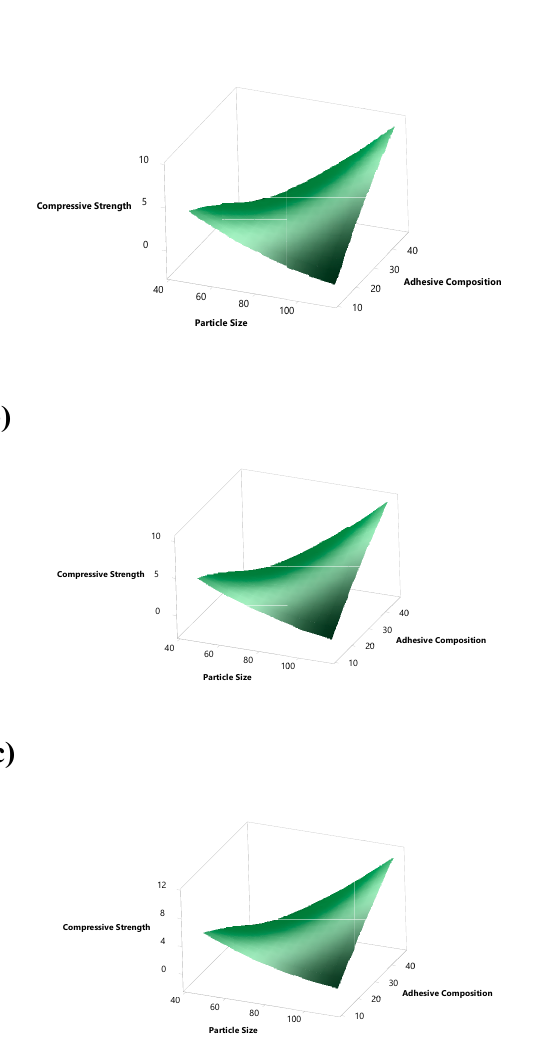
Figure 8. Graph and contour of surface response influences the adhesive composition and particle size to compressive strength at the pressing pressure ( a ) 100 ( b ) 110, and ( c ) 120 kg / cm 2 In the adhesive composition of 80:20 palm oil charcoal, the highest compressive strength of 1611 kg / cm 2 was obtained under 60 mesh particle size conditions and pressing pressures of 100 kg / cm 2 , while the lowest compressive strength of 1302 kg / cm 2 was obtained under 100 mesh particle size conditions and pressing pressures of 100 kg / cm 2 . In the composition of the adhesive against palm oil charcoal 70:30, the highest compressive strength of 5.346 kg/cm 2 was obtained under 120 mesh particle size conditions and a pressing pressure of 110 kg/cm 2 and the lowest compressive strength at 1.202 kg/cm 2 under 50 mesh particle size conditions and a pressure pressing of 110 kg/cm 2 . Likewise, for the adhesive composition of palm bar charcoal 60:40, the highest compressive strength of 7526 kg/cm 2 was obtained under 100 mesh particle size conditions and a pressing pressure of 120 kg/cm 2 , while the lowest compressive strength of 0.86 kg/cm 2 was found under 60 mesh particle size conditions and 100 kg/cm 2 pressing pressure. Figure 9 shows that the composition of the changing matrix gave a different compressive strength under the same conditions of particle size and pressing pressure.